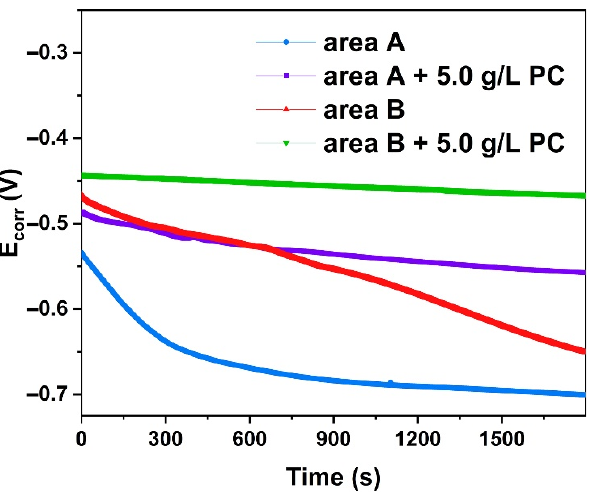
Figure 14. Corrosion potential of archaeological steel before and after conversion with